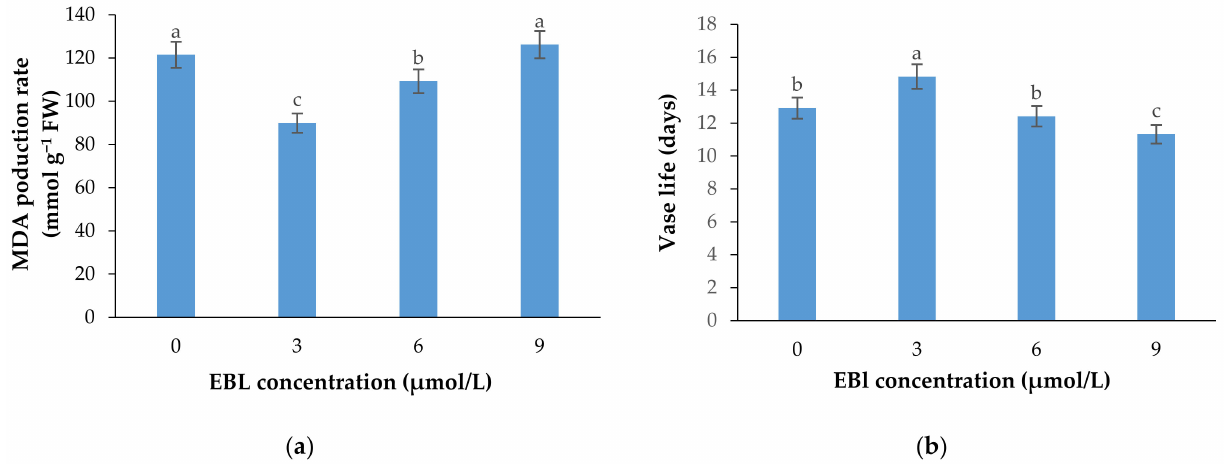
Figure 6. Mean data for the effects of EBL at different concentrations on MDA production rate ( a ) and vase life ( b ) of lisianthus cut flowers. Error bars represent the standard error of means of four replicates. Columns indicated by different letters are significantly different according to Duncan’s multiple range test ( p ≤